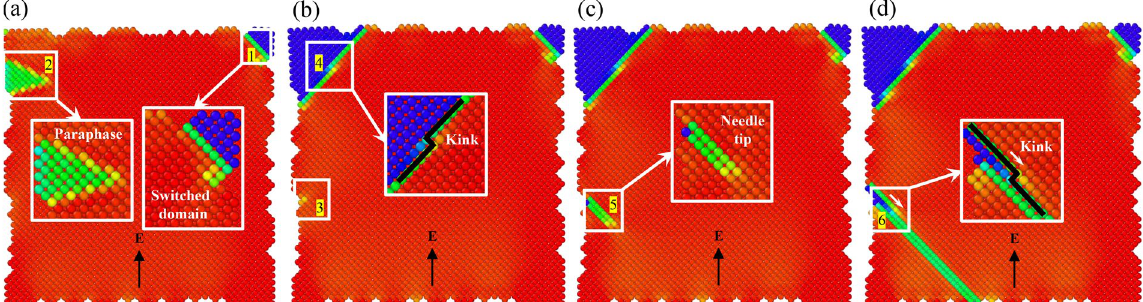
Figure 3. The evolution of domain pattern driven by the external electric field. ( a ) Nucleation of new domains. Site 1 shows the switched domains. Site 2 shows the intermediate state during transition. ( b ) Growth of new domain and nucleation of needle domain. Site 3 shows the transient nucleation state of needle domain from the rough surfaces. Site 4 shows the stable new domain after switching. ( c ) The propagation of needle domains nucleated from site 3. ( d ) The propagation of domain wall via the moving kink, as marked in site 6.